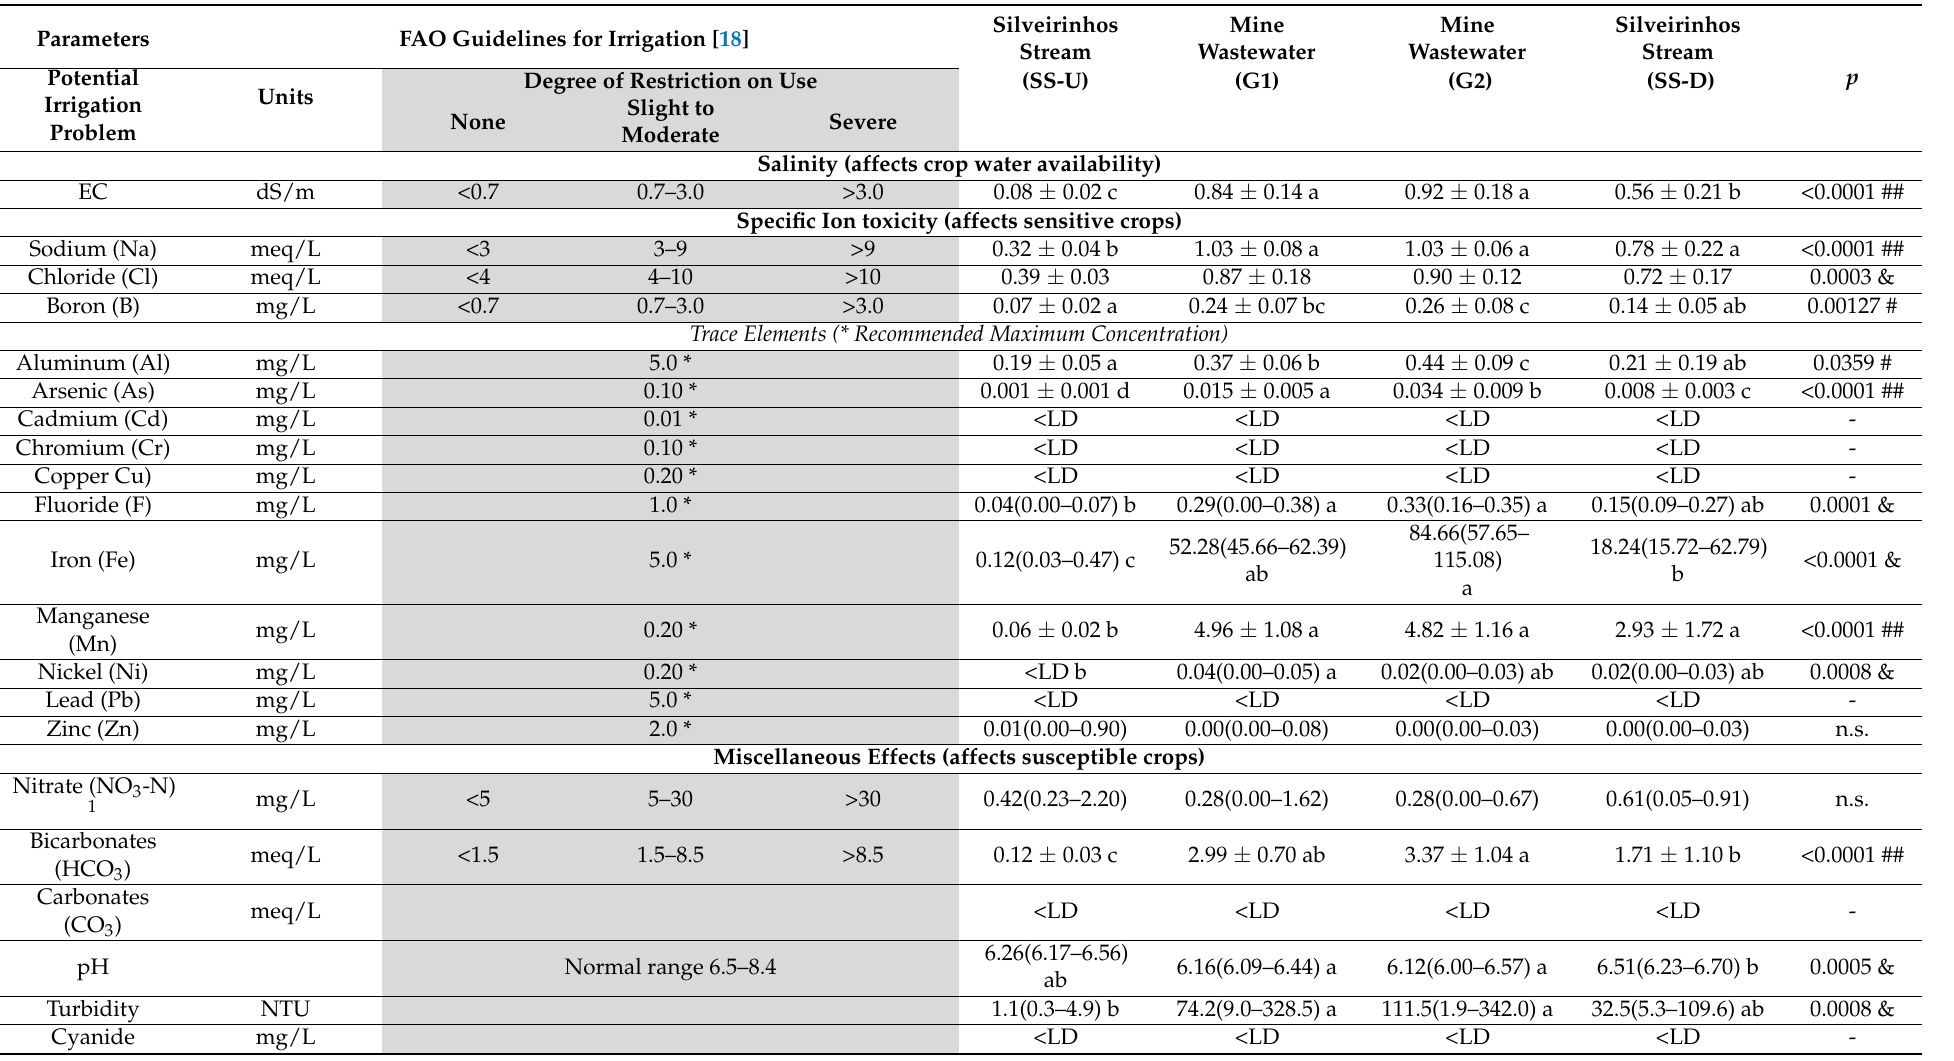
Table 3. Summary statistics of physical and chemical parameters analyzed in mining effluents and in Silveirinhos stream. Comparison with FAO Guidelines for